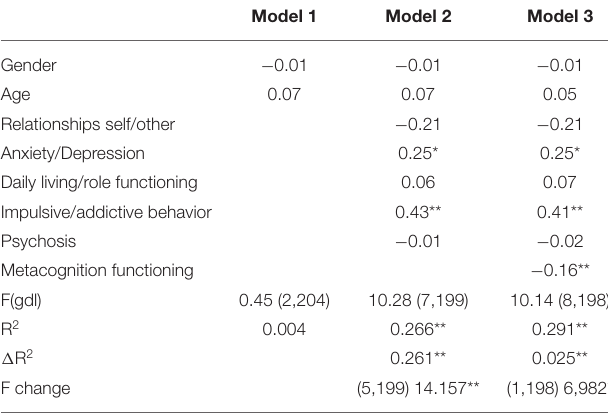
TABLE 2 | Hierarchical regression Models’ fit indexes and standardized